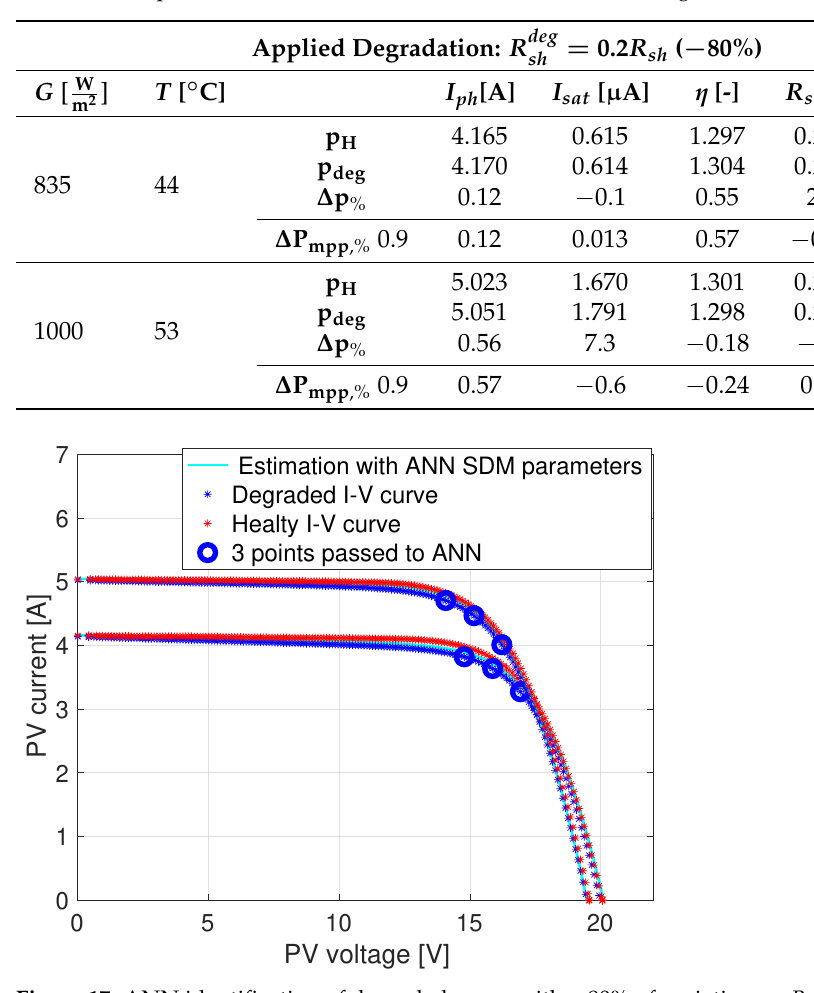
Figure 17. ANN identification of degraded curve with − 80% of variation on R sh for two different irradiance and temperature